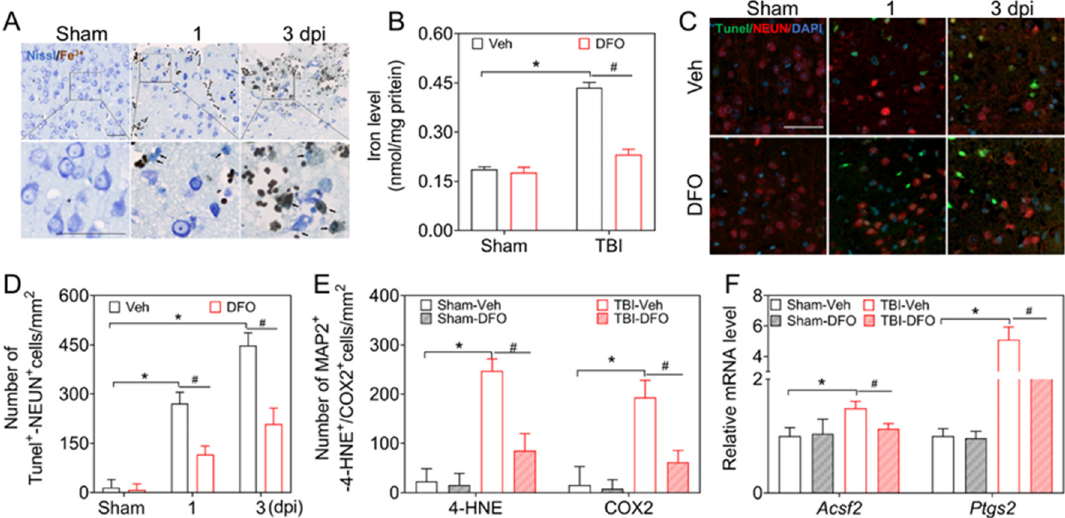
Figure 1. Deferoxamine (DFO) improves ferroptosis after traumatic brain injury (TBI). ( A ) Representative images of iron staining in Nissl-positive cells at 1 and 3 dpi. n = 3, bar = 50 µ m. ( B ) Iron levels in the injured cortex of WT mice at 3 dpi with Veh or DFO treatment, n = 6. ( C ) Co-localization of NEUN and TUNEL in injured cortex at 1 and 3 dpi after Veh or DFO treatment. n = 3, bar = 50 μ m. ( D ) Diagram of TUNEL-NeuN-positive cells in the injured cortex treated with DFO and Veh at 1 and 3 dpi, n = 3. ( E ) Diagram of the 4-HNE- and COX2-positive cells in injured cortical neurons at Ptgs2 in the injured cortex of mice treated with Veh or DFO, n = 6. Data are expressed as mean ± SD, * p < 0.05 vs. sham—Veh, # p < 0.05 vs. TBI—Veh. Two-way analysis of variance was followed by Tukey’s post hoc multiple comparison test for comparisons between more than two groups. Veh, vehicle; DFO, deferoxamine.